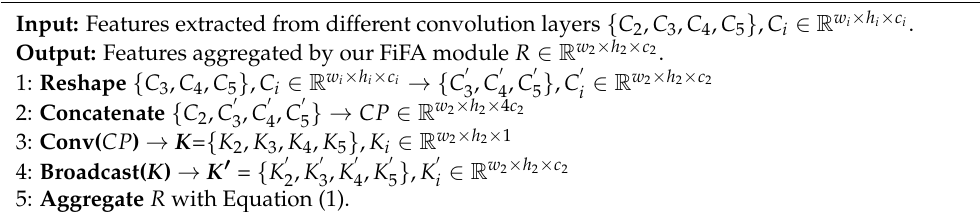
Algorithm 1 The pseudo-code for aggregating fine-grained features with our FiFA module.